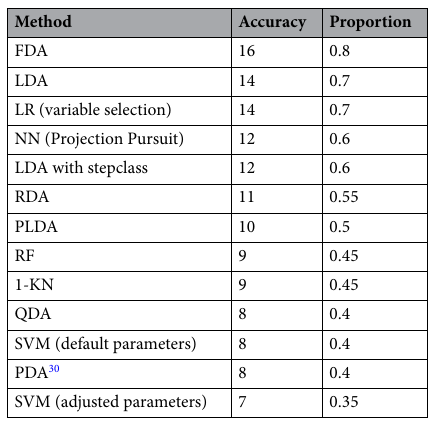
Table 4. LOU results for the 13 classifiers. The Accuracy column contains the number of correct predictions, whereas the Proportion column contains the success